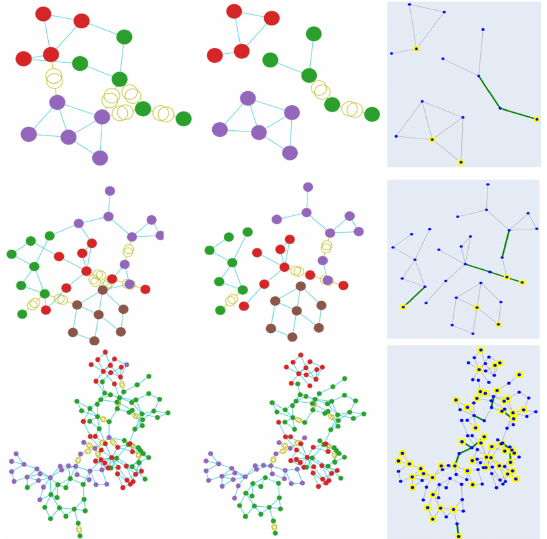
Figure 5. Clustering visualisation of the results obtained by using the GAP loss function. Each color represents a specific cluster. The first row displays the results from case 14, followed by case 30 and case